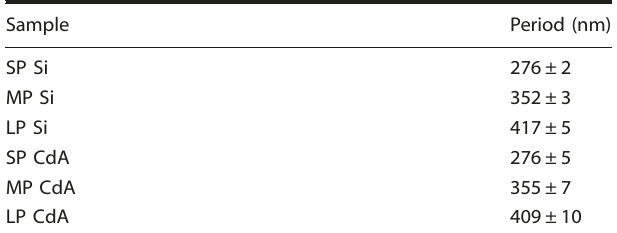
Table 1. Grating periods determined from GISAXS diffraction patterns of Si molds and the corresponding CdA replica